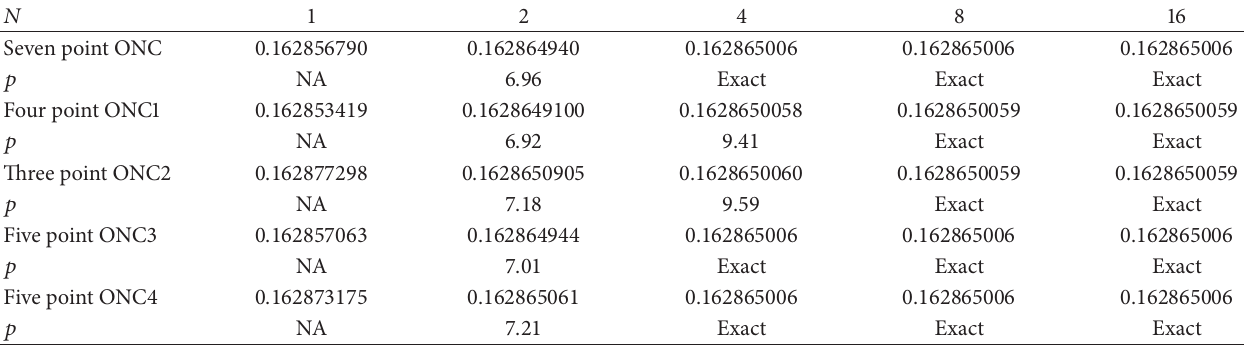
1 (𝑥 ln (1 + 𝑥)/(1 + 𝑥 2 ))𝑑𝑥 . 0